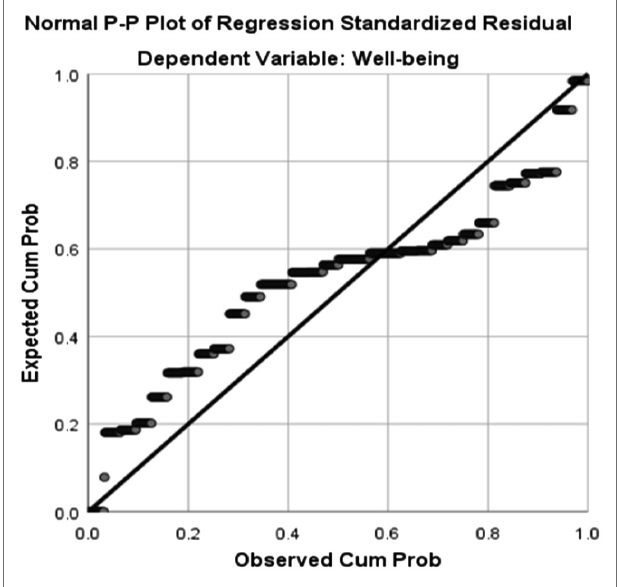
FIGURE 1 | Normal probability plot (P–P) of the regression standardized residual (teachers’ wellbeing is the dependent variable).